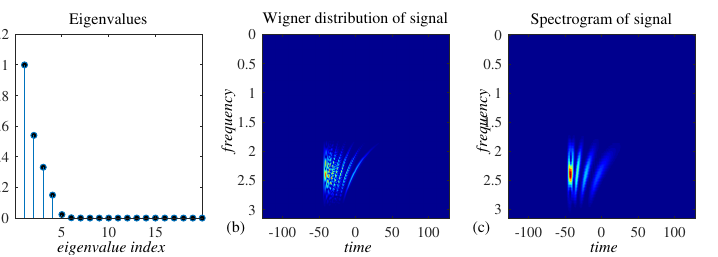
Figure 15. ( a ) Eigenvalues of autocorrelation matrix R , ( b ) Wigner distrubution and ( c ) spectrogram of the considered acoustic signal from the dispersive environment. The number of sensors is C = 25, whereas the number of modes is P = 5.